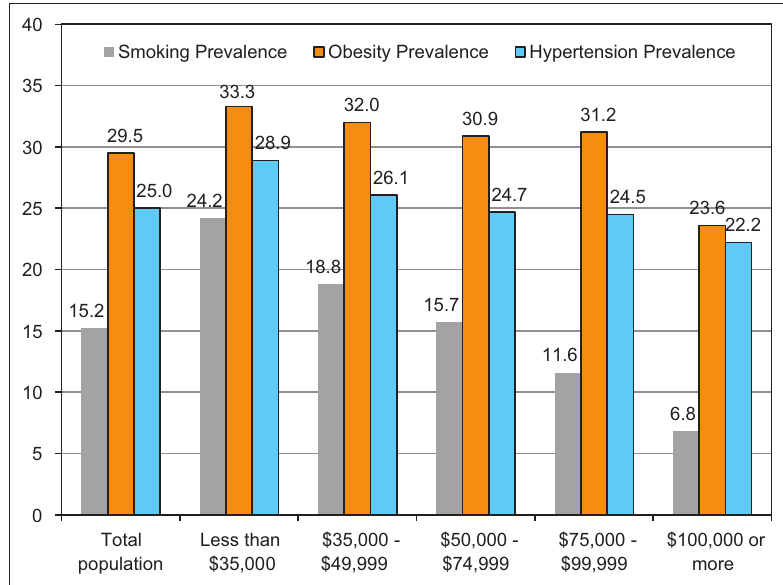
Figure 27. Age-Adjusted Prevalence (%) of Current Smoking, Obesity, and Hypertension by Family Income, US Adults Aged 18 Years and Older, 2015 Source: CDC/NCHS. 2015 National Health Interview